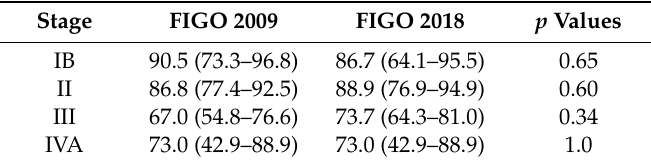
FIGO, International Federation of Gynecology and Obstetrics. Data are % (95% confidence intervals). p values calculated from the log-rank test are shown.